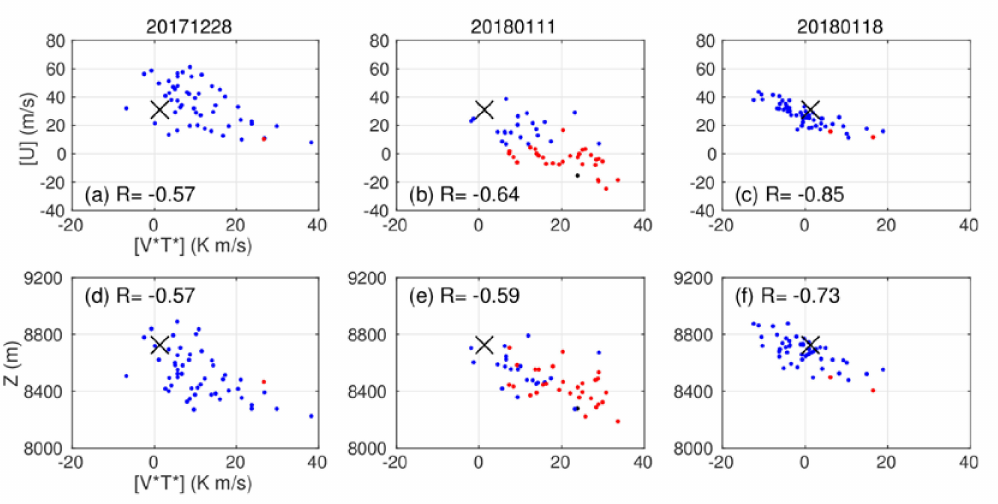
Figure 11. Same as Figure 5, but for the second cluster. Panels ( a – c ) plot the heat flux and zonal wind. Panels ( d – f ) use the 300 hPa height averaged over 65 ± 10 ◦ N, 150 ± 15 ◦ E instead of the zonal wind. Figure 12b,c compare 300 hPa height fields between the MSSW and non-MSSW member means. The comparison shows lower values, indicating a more pronounced upper-air low or trough, over ◦ ◦ northeastern Eurasia around 65 N, 150 E (Figure 12d). This location corresponds to where the climatological wave field has a trough (Figure 7). This signal is again reminiscent of the observational result [28,29].